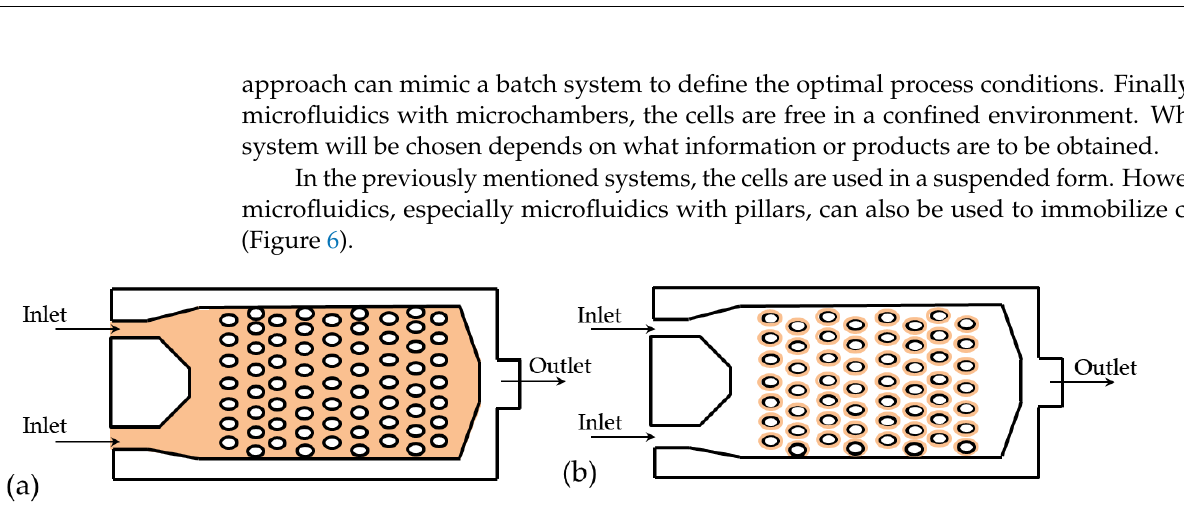
12 of 24 Figure 5. Schematic diagram for ( a ) microfluidics with different mechanical traps/pillars, ( b ) micro- fluidics for droplet formation, and ( c ) microfluidics with microchambers.